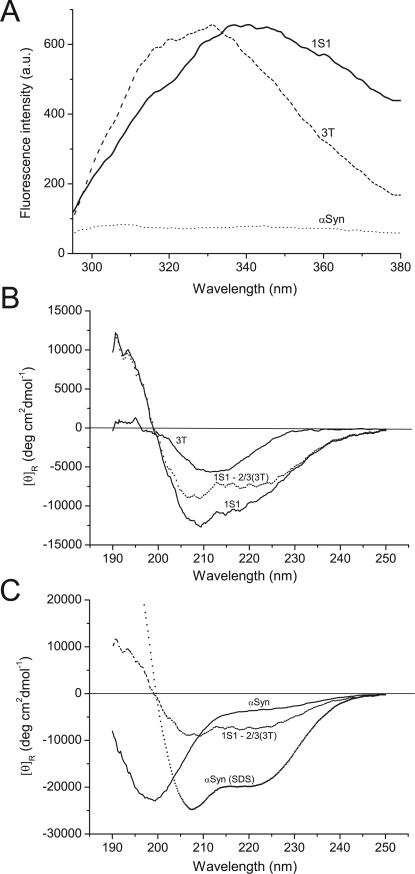
Circular Dichroism and Fluorescence Spectroscopy(A) Fluorescence spectra of αSyn, 3T, and 1S1 (dotted, dashed, and solid line, respectively).(B) Circular dichroism spectra in PBS buffer of 3T, 1S1 (solid lines). The αSyn contribution in 1S1 (dashed line) is calculated by subtracting the relative contribution of the I27 domains from the CD spectrum of 1S1.(C) CD spectra of αSyn in PBS (solid line) and 250 mM SDS (dotted line). The αSyn contribution in 1S1 (dashed line) is reported as in (B).